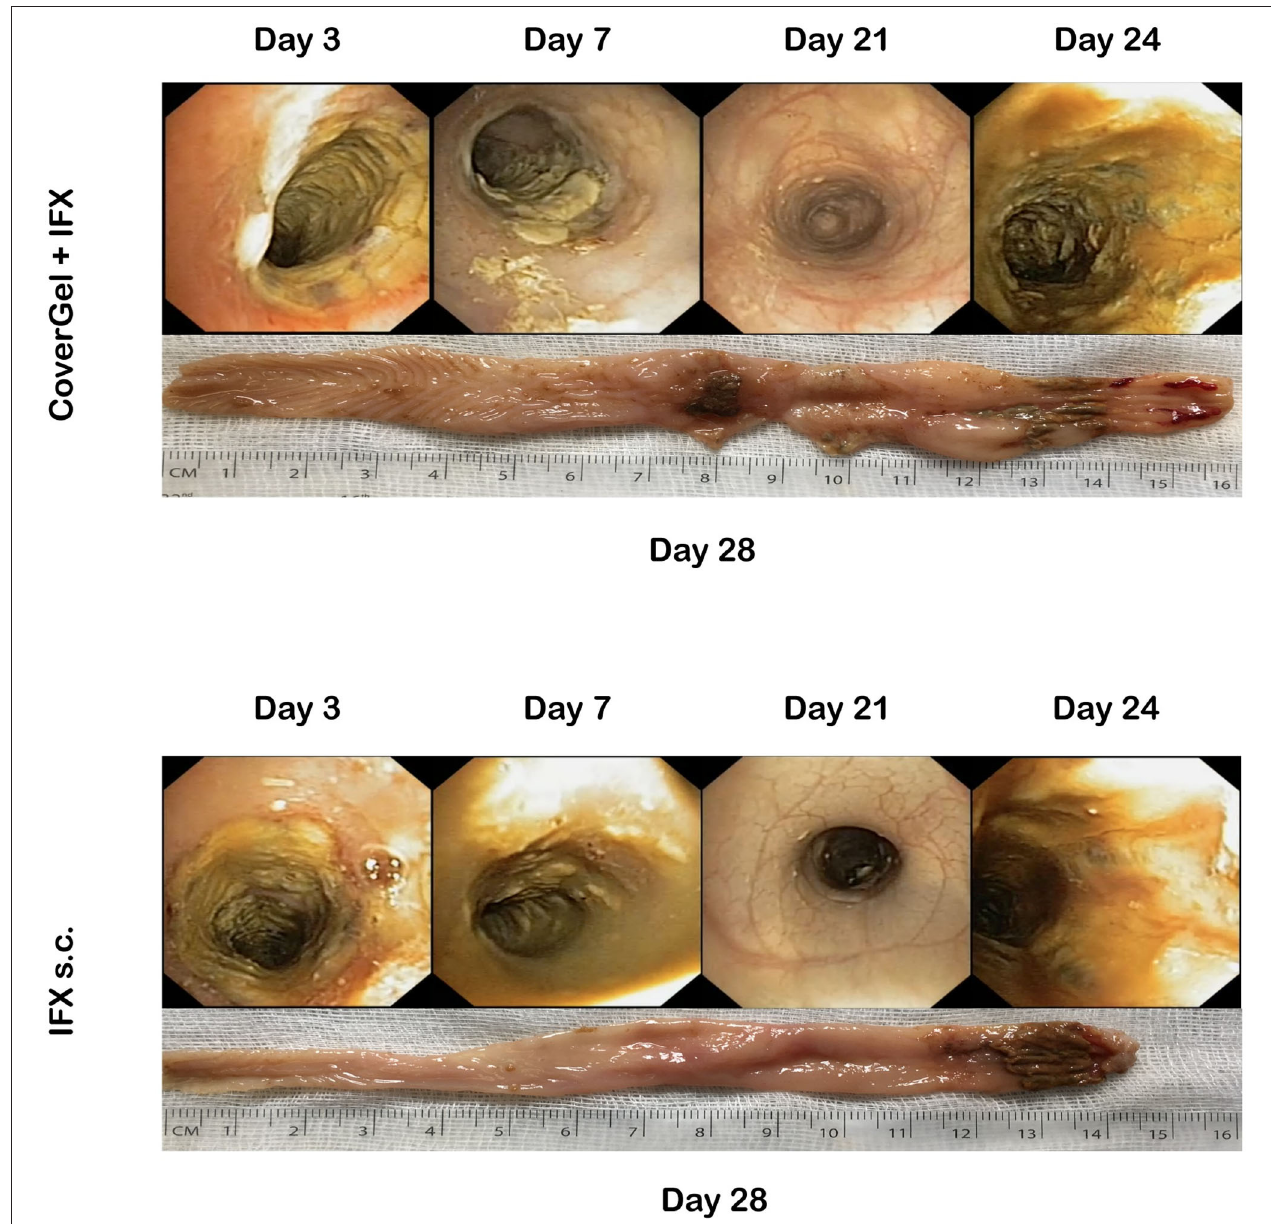
FIGURE 7 | Endoscopic and macroscopic representative images of the chronic EC animal model. Endoscopic images from day 3 (first treatment application), day 7 (second TNBS induction), day 21 (fourth TNBS induction), day 24 (fourth treatment application), and macroscopic image of day 28 (day of